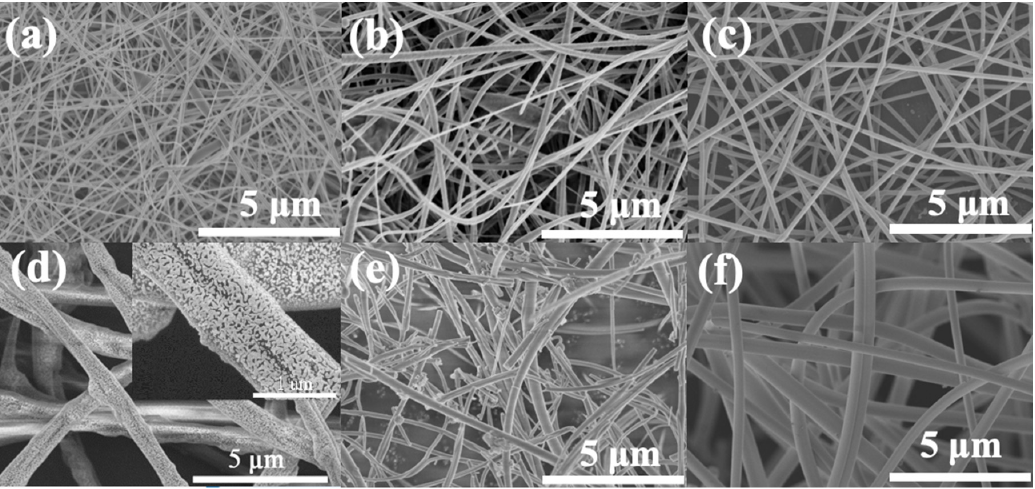
Figure 12. Nanofibers prepared by critical bubble electrospinning, ( a ) 7 wt % PVA / aqueous solution (mean diameter: about 114 nm), ( b ) 28 wt % PES / DMF (mean diameter: about 187 nm), ( c ) 30 wt % PVP / distilled water / ethanol (mean diameter: about 146 nm), ( d ) 8 wt % PAN / ZrCl 2 · 8H 2 O / DMF / ethanol (mean diameter: about 884 nm) and ( e ) its product obtained after calcination at 1000 ◦ C in air (mean diameter: about 226 nm) and ( f ) PI nanofibers from 24% ODA / DMAC / PMDA precursor (mean diameter: about 432 nm).